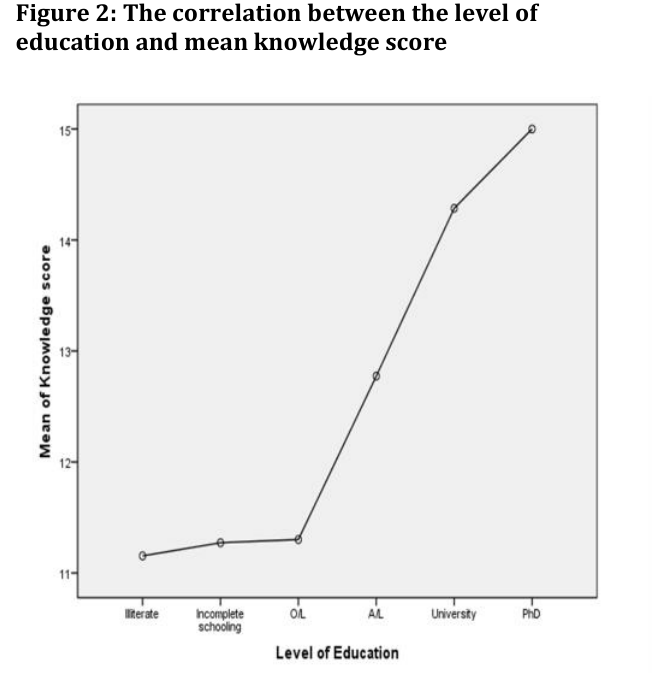
Figure 2: The correlation between the level of education and mean knowledge